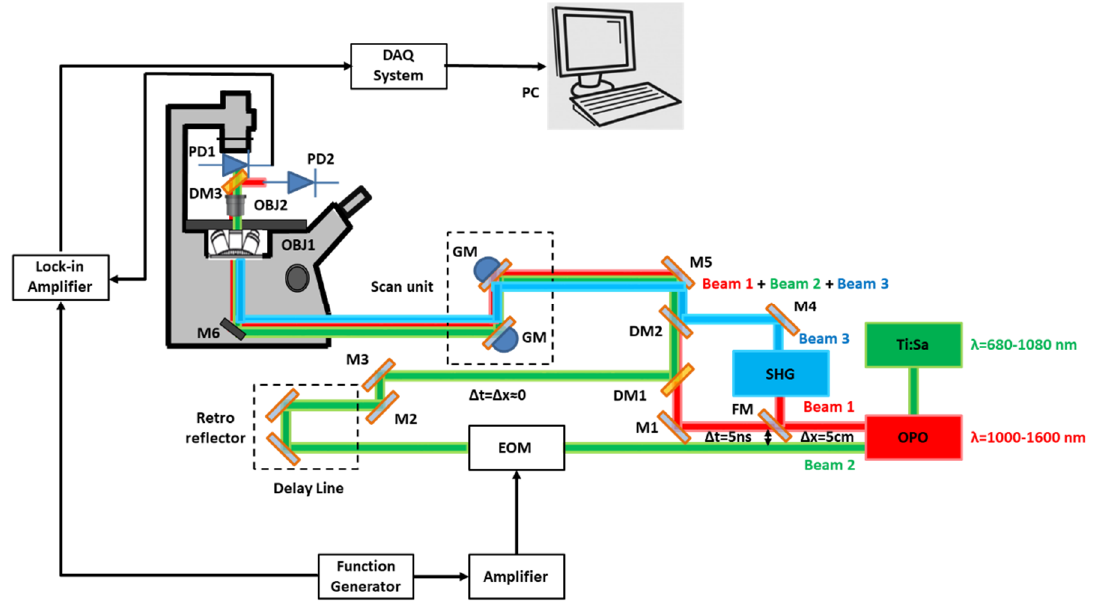
Figure 1. Experimental setup. Ti:Sa = titanium–sapphire (Ti:Sa) oscillator; OPO = optical parametric oscillator; SHG = second harmonic generation, M1-M6 = femtoseconds mirrors; FM = flip mirror; DM1, DM2, DM3 = dichroic mirrors; EOM = electro-optic modulator; GM = galvo mirrors; OBJ1, OBJ2 = objective lens; PD1 = photodiode (Si detector) for SRL measurements; PD2 (InGaAs detector) for SRG measurements.